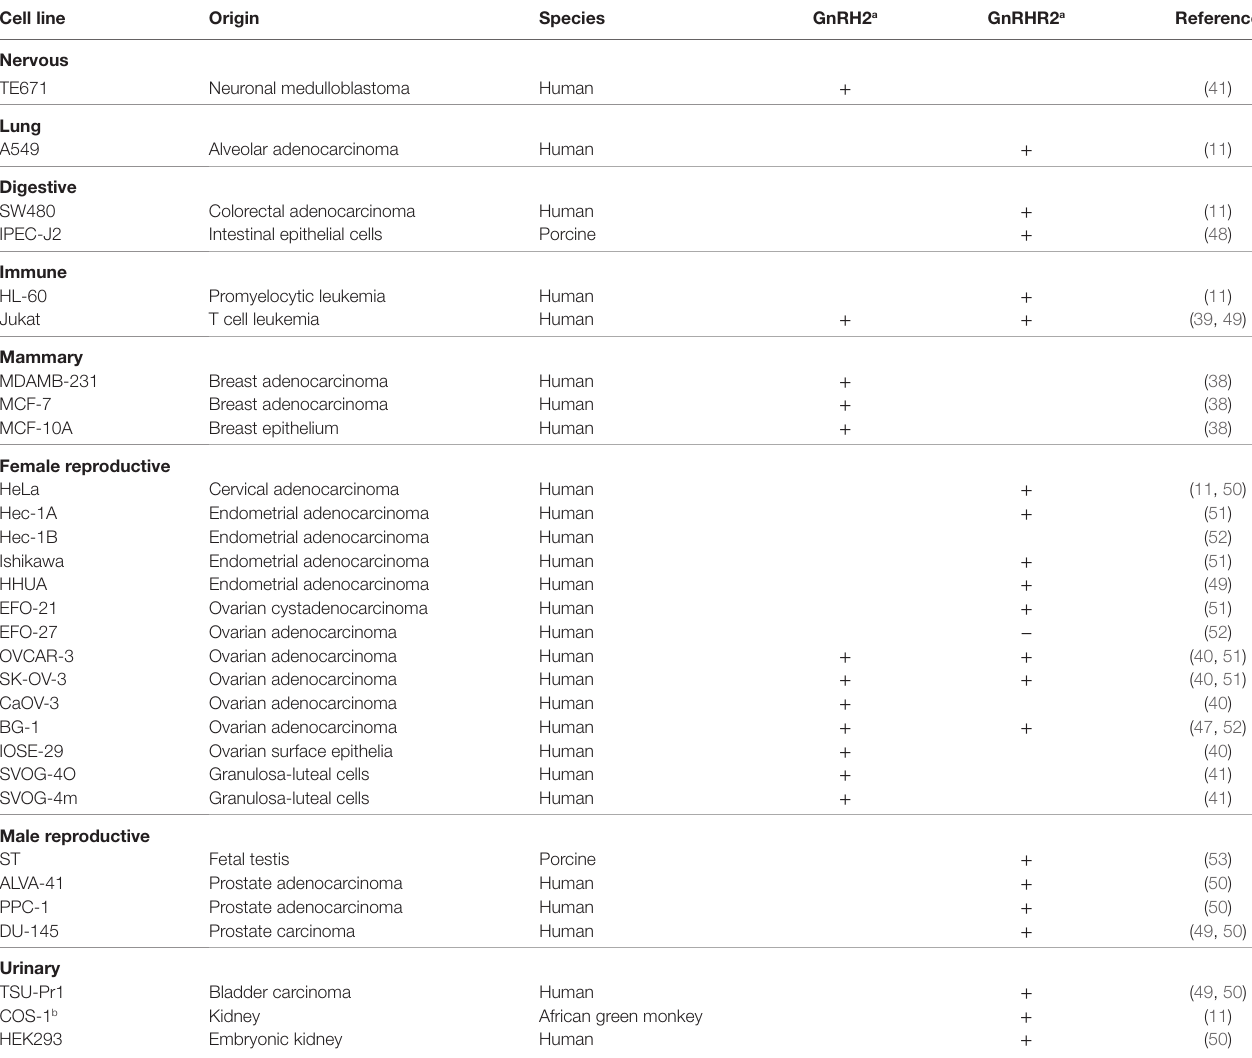
TABLe 4 | Production of GnRH2 and GnRHR2 in mammalian cell